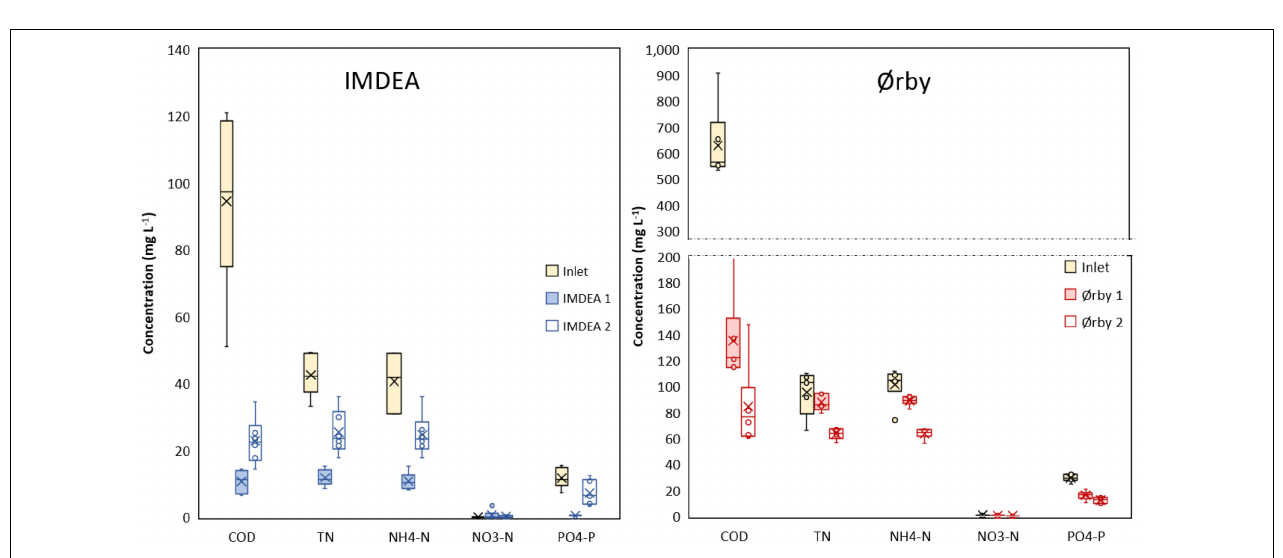
FIGURE 3 | Plan view and profile of the METland system at Ørby. Both parallel systems were planted with Phragmites australis . Sample points B1 and B2 were located in the bed at the position marked in the figure.